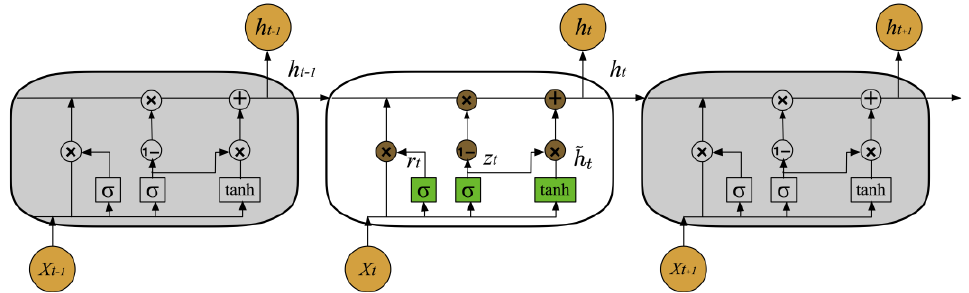
Figure 10. Schematic diagram of trajectory prediction model based on GRU.